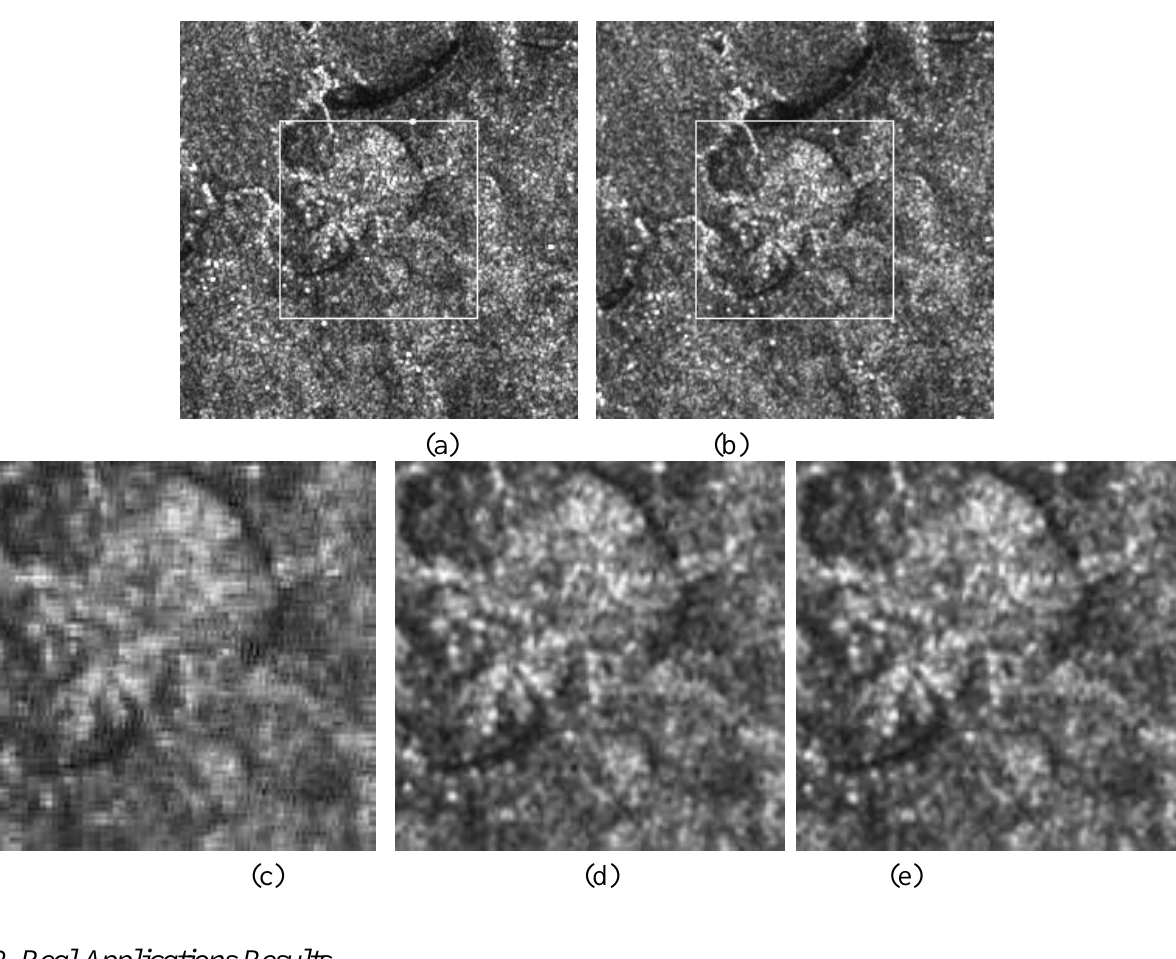
Figure 9. Registration of SAR images (with inherent speckle noise) using the three methods: (a) reference image, (b) transformed image to be corrected, (c) registered image using wavelet, (d) registered image using the first proposed method, and (e) the corrected image using the second proposed